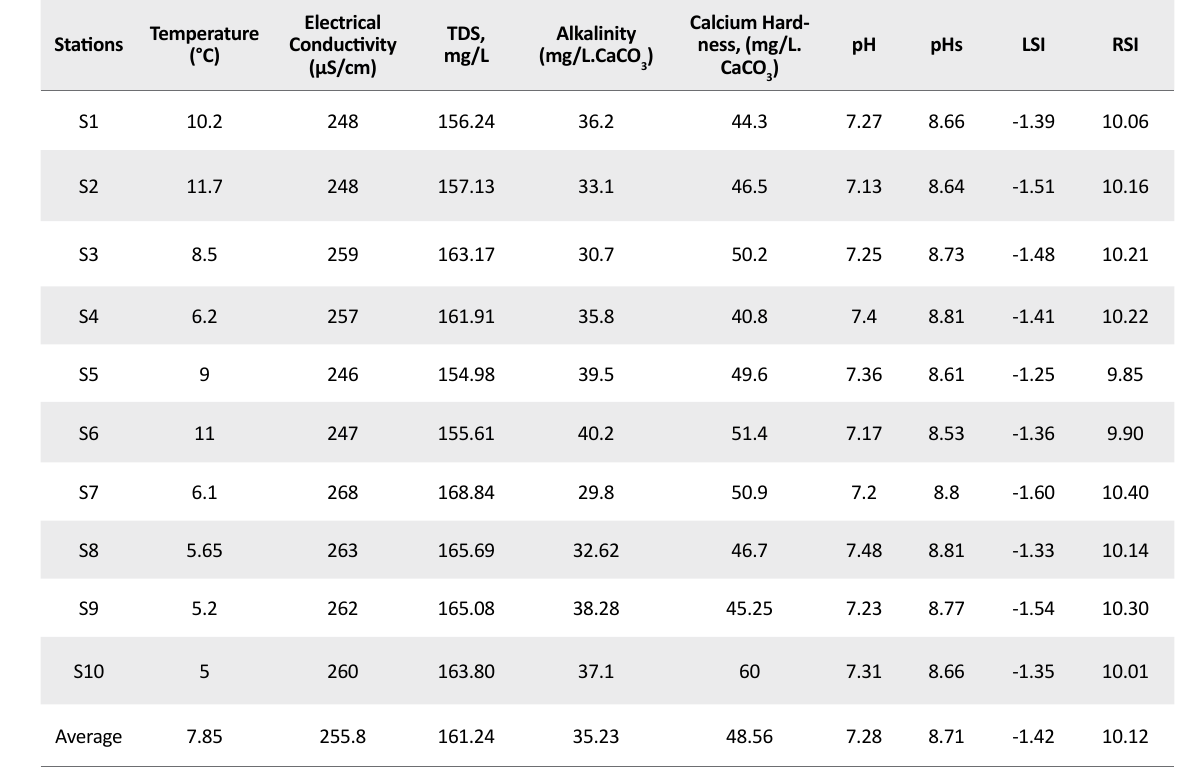
Table 4. Results of chemical analysis of drinking water in Meshginshahr City (second stage of sampling in the Winter)